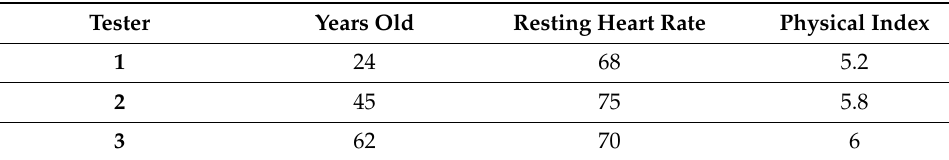
Table 6. Three testers’ experiment result.